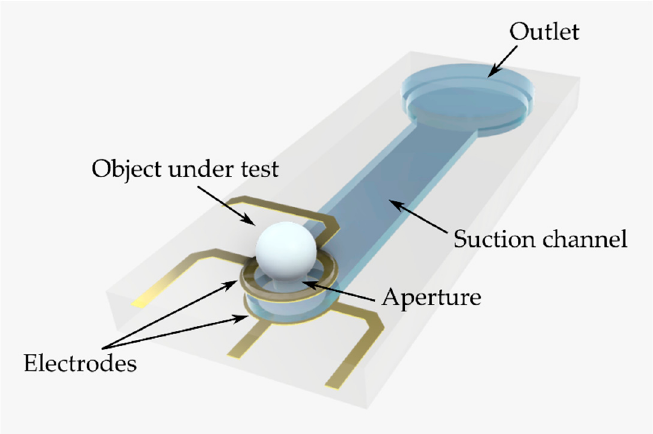
Figure 1. 3D schematic depiction of the microfluidic chip. An object is trapped and fixed at the aperture through the microfluidic suction channel. The object is characterized by electrical impedance spectroscopy using two vertically adjusted, ring-shaped microelectrodes around the aperture. Drawing not to scale.